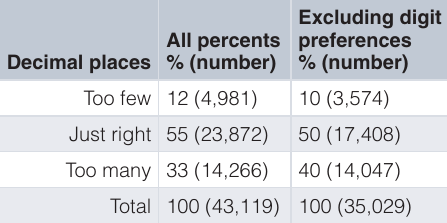
Table 1. Percent and number of percents in abstracts where the guidelines on decimal places were used or